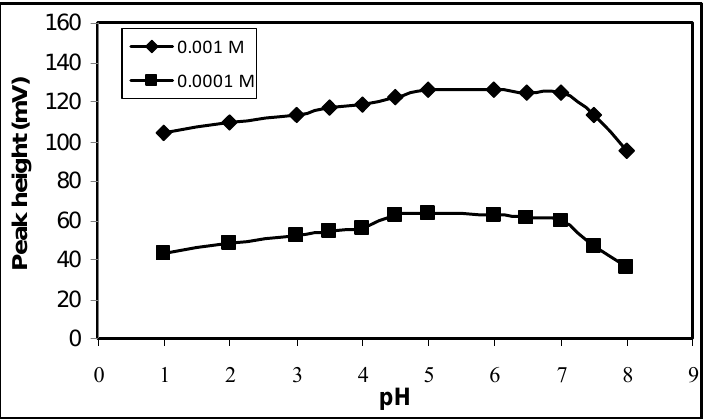
Figure 4. pH profile of sensor no. 10. Carrier stream, 0.1 M acetate buffer; injection loop, 150 μ L; flow rate; 3.25 mL min − 1